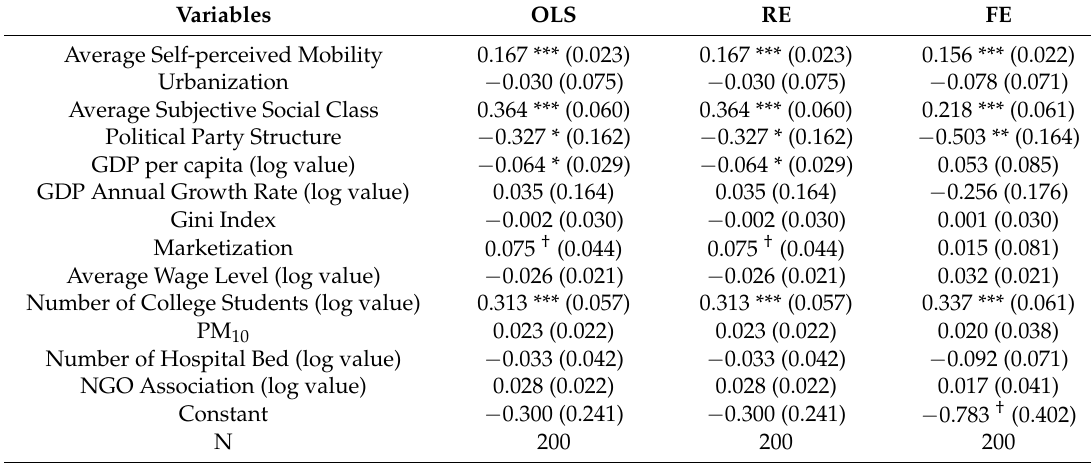
Table 6. Static Panel Regression Predicting Provincial Health Level